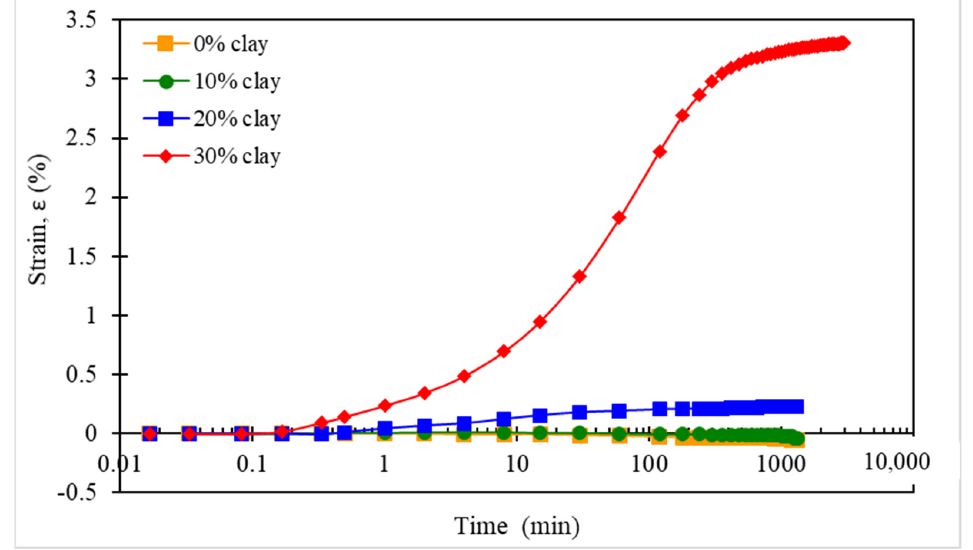
Figure 3. Vertical strain vs. time for sand–clay